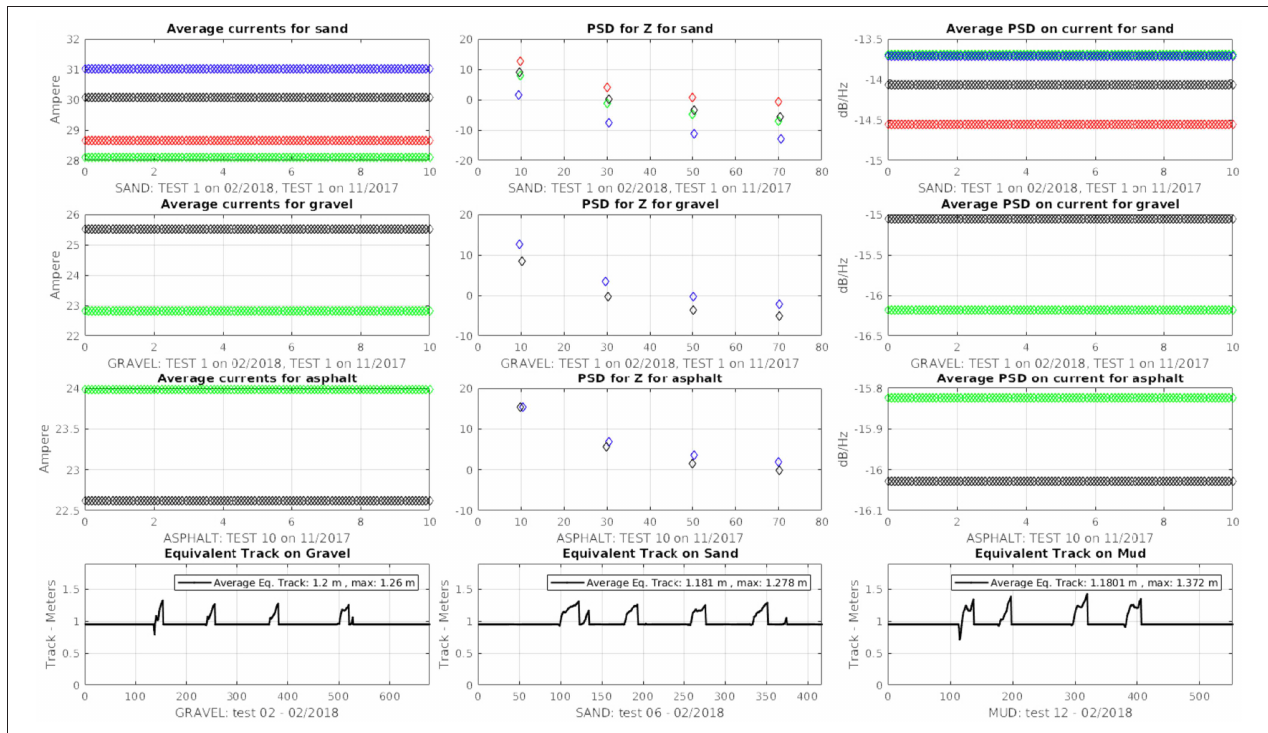
FIGURE 13 | Reference values for some terrain profiles.